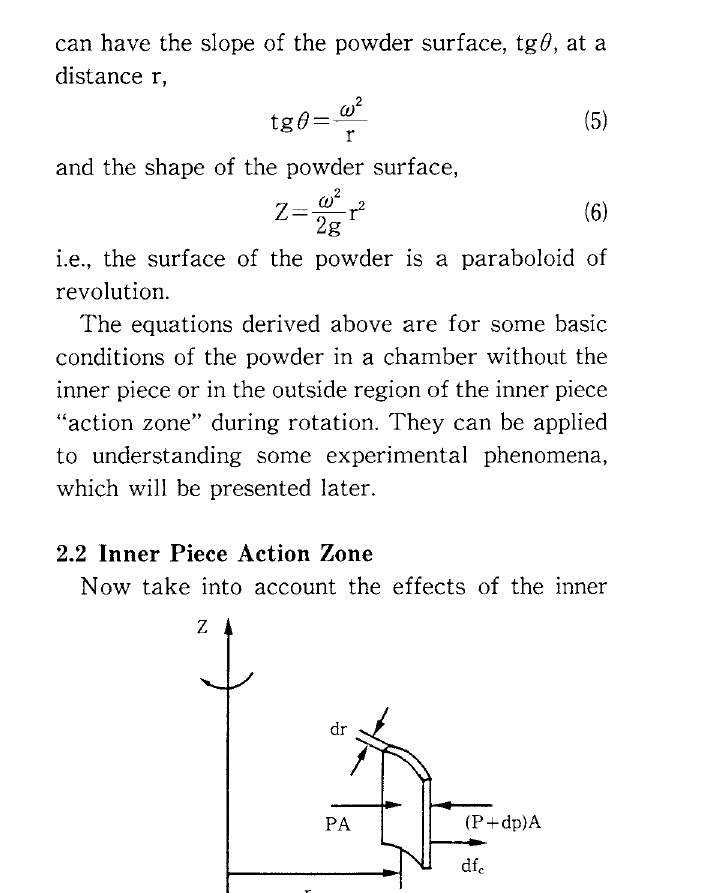
Fig. 1 Small volume element within the powder.